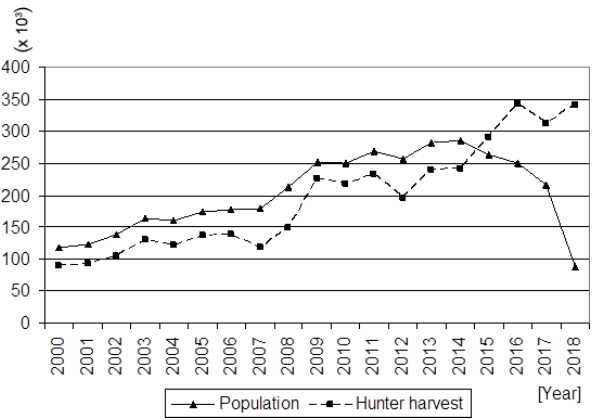
Figure 1. Population and hunter harvest of wild boars in Poland (own study based on the Concise Statistical Yearbook of Poland,